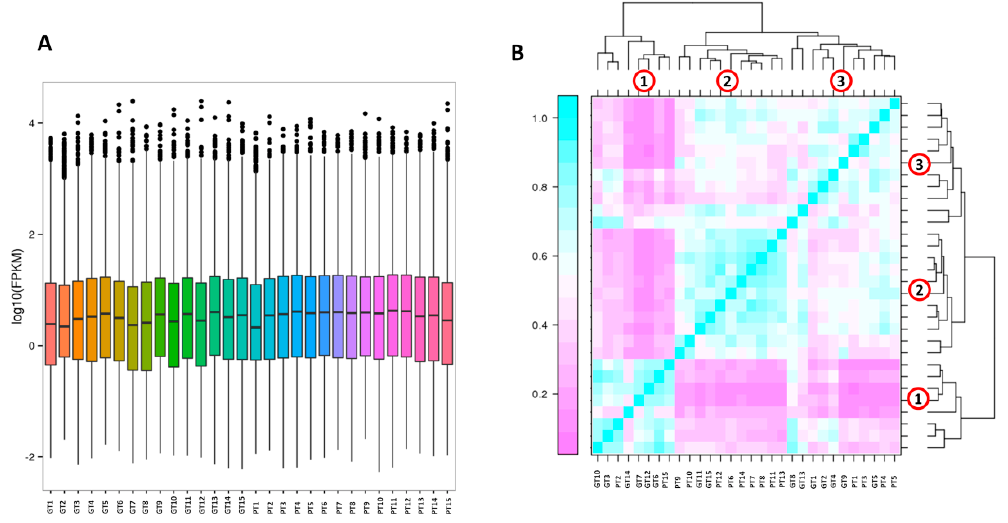
Figure 2. Overview of the transcriptome sequencing. ( A ) Gene expression profiles in the 30 libraries. PT represents the purple turnip while GT represents the green turnip; ( B ) heatmap clustering showing correlation among turnip samples based on global expression profiles. The number 1, 2 and 3 represent the 3 Clusters of samples.